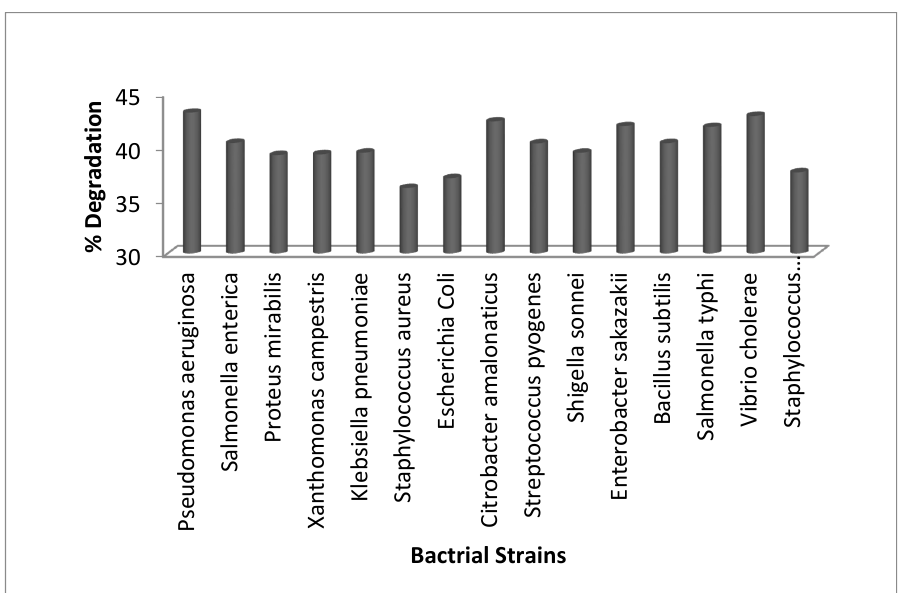
Figure 2. Percent degradation of selected dye different bacterial strains (20 ppm concentration, 37°C, 15 mL broth medial mixed with bacterial inoculum taken from bacterial suspension of 10 8 – 10 9 CFU/mL, incubated for 3 days at neutral pH).